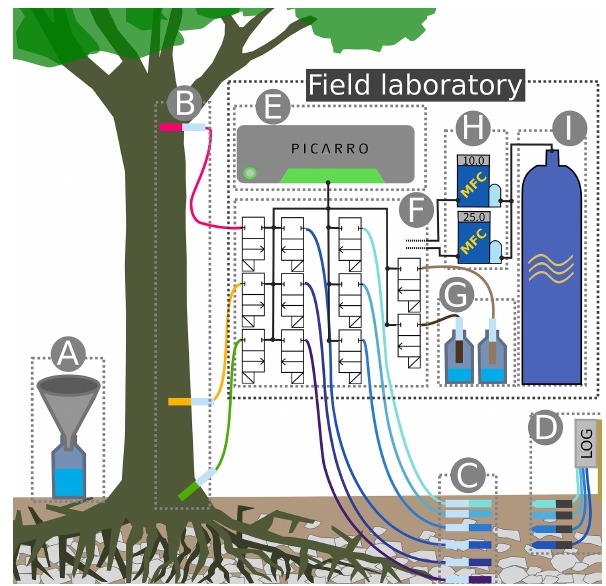
Figure 2. Sketch of the experimental setup: (A) throughfall sam- pler; (B) WIPs at 10, 150 and 800cm stem height; (C) WIPs in 10, 20, 40, 60, 80 and 100cm soil depth; (D) volumetric soil moisture sensors in 10, 20, 40 and 60cm depth; (E) CRDS for stable wa- ter isotope measurements; (F) valve system to sequentially connect each probe to the CRDS and the two mass flow controllers; (G) stan- dard probes in headspace of liquid water standards; (H) mass flow controllers; (I) dry air for sample dilution and